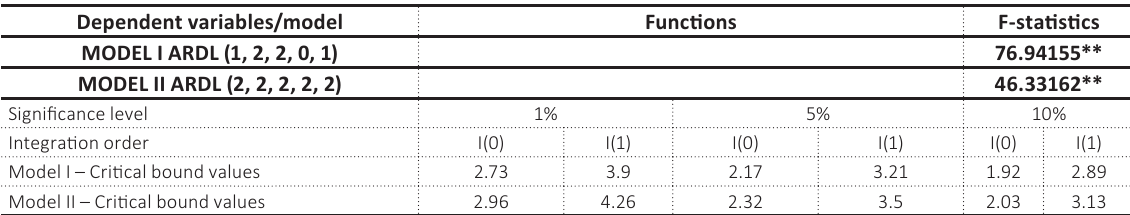
Source: Authors’ computation (2020).